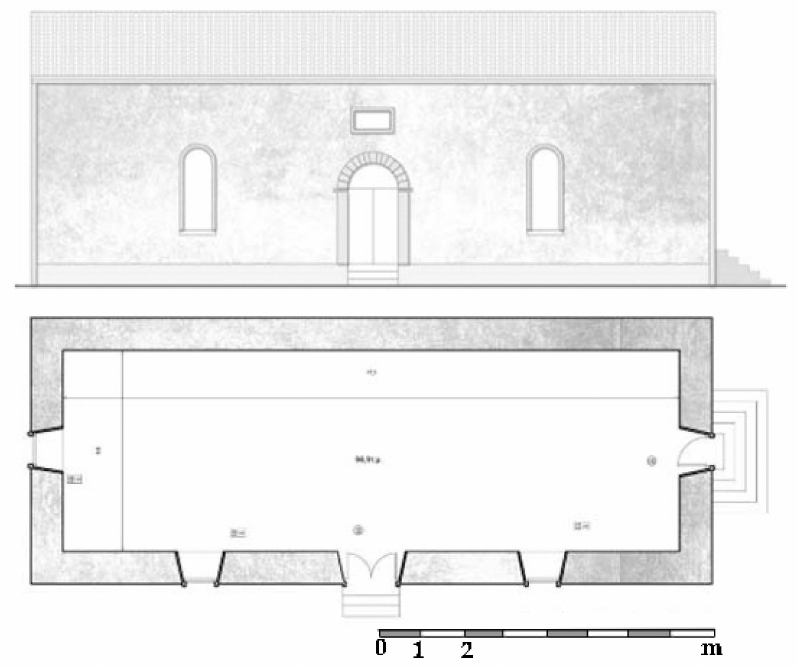
Figure 18. Façade and ground plan of the English School of Potamos in Kythera, Greece.